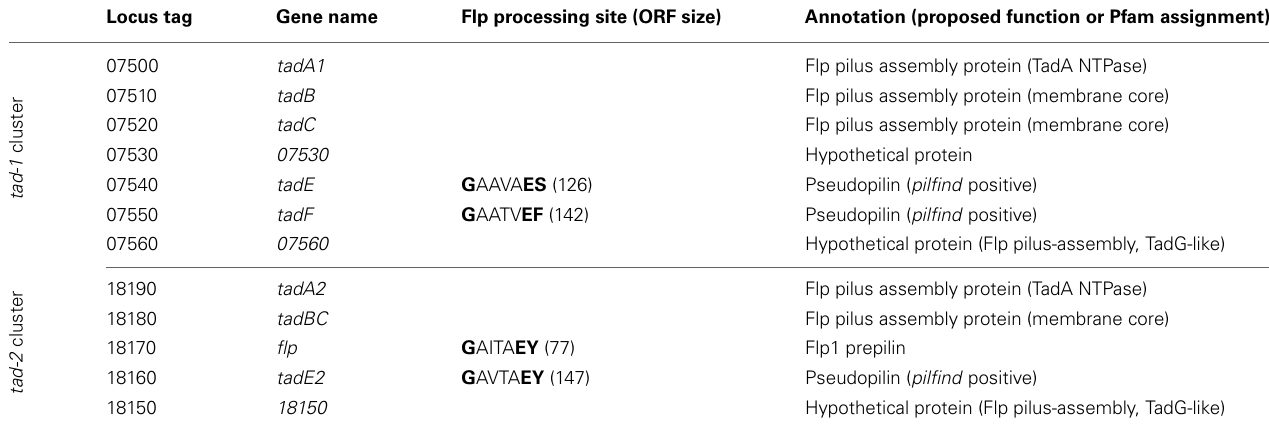
Table 1 | Genes of the tad gene clusters of M. luteus trpE16 identified as required for natural transformation * . Locus tag